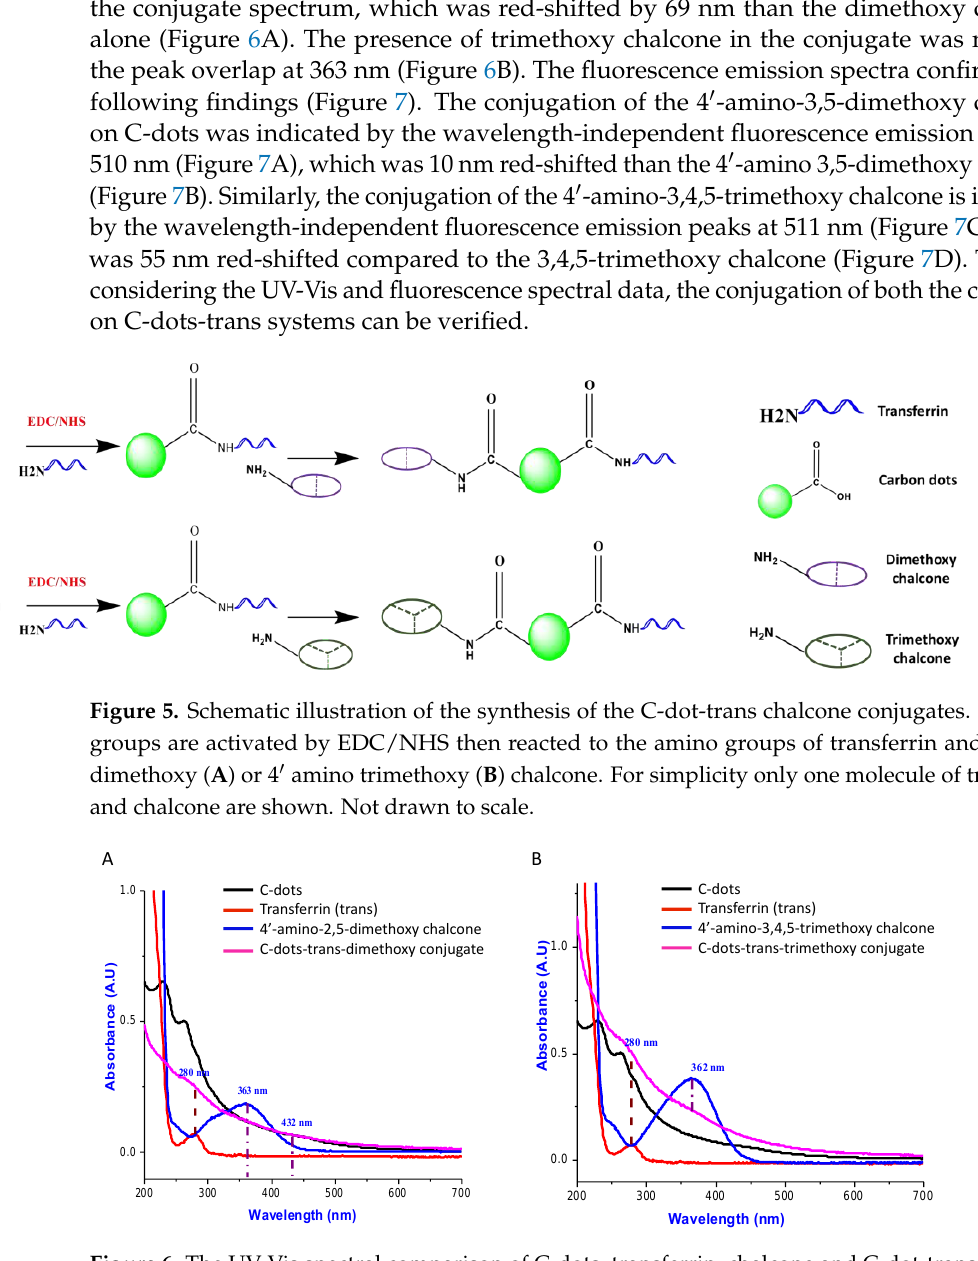
Figure 6. The UV-Vis spectral comparison of C-dots, transferrin, chalcone and C-dot-trans-chalcone. ( A ) Free C- dots transferrin, dimethoxy chalcone 3f (4′amino - 3,5,dimethoxy), and C-dots-trans-di- methoxy conjugate. ( B ) Free C- dots, transferrin, trimethoxy chalcone 3e (4′ -amino-3,4,5-trimethoxy) and C-dots-trans-trimethoxy conjugate. Samples (20 μg/mL) were tested in a 1 cm quartz cell.